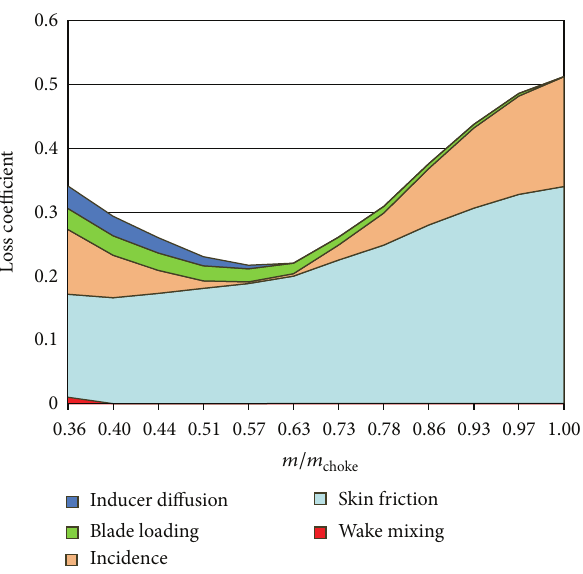
Figure 6: Loss coefficient distribution of impeller.